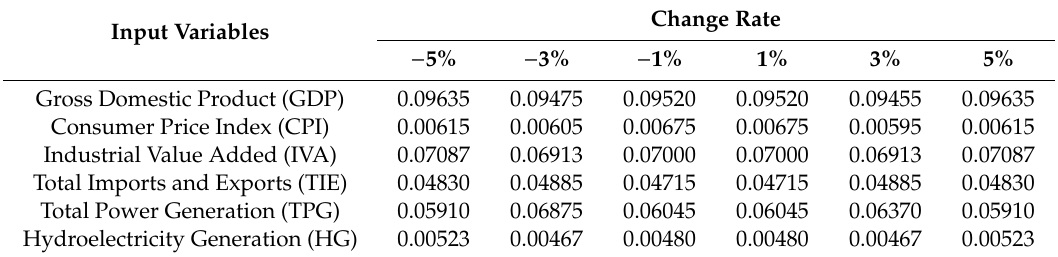
Table 4. The maximum sensitivity of wind power generation with respect to the six